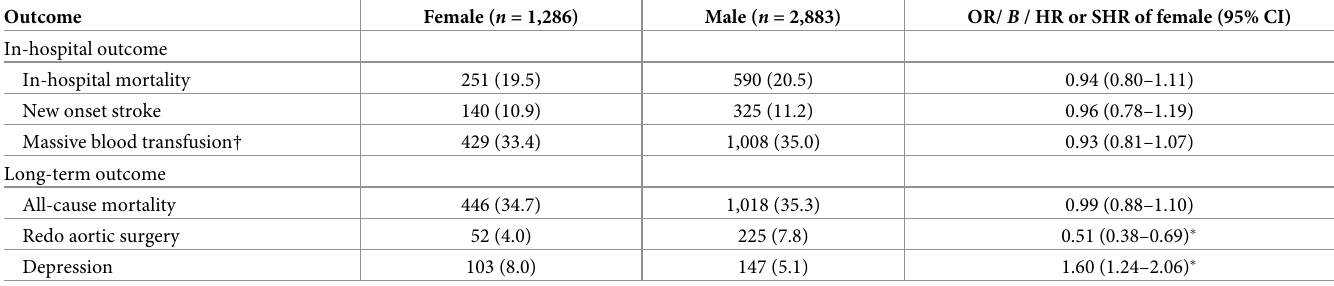
OR, odds ratio; B , regression coefficient; HR, hazard ratio; SHR, subdistribution hazard ratio; CI, confidence interval; PRBC, packed red blood